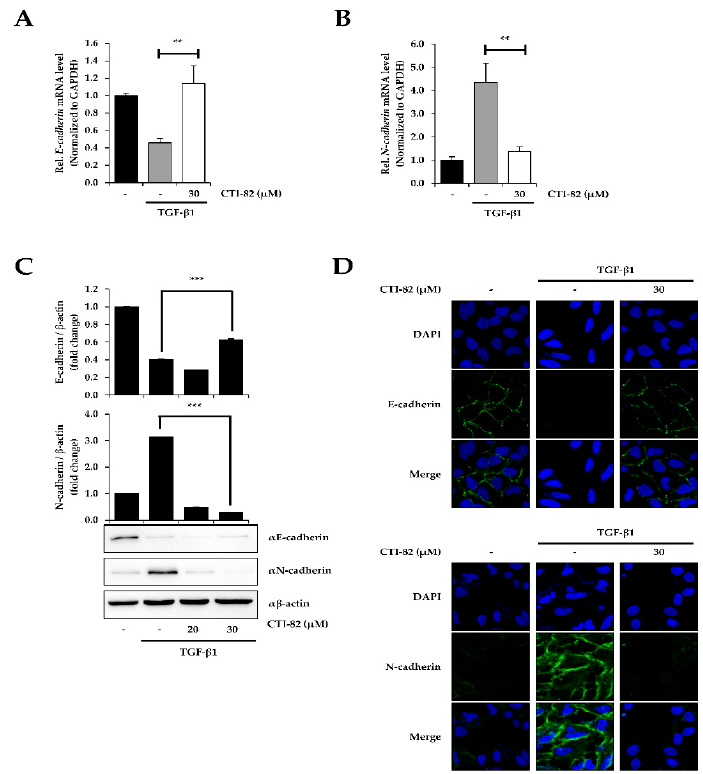
Figure3. CTI-82antagonizesTGF- β 1-inducedepithelial–mesenchymaltransition(EMT).( A